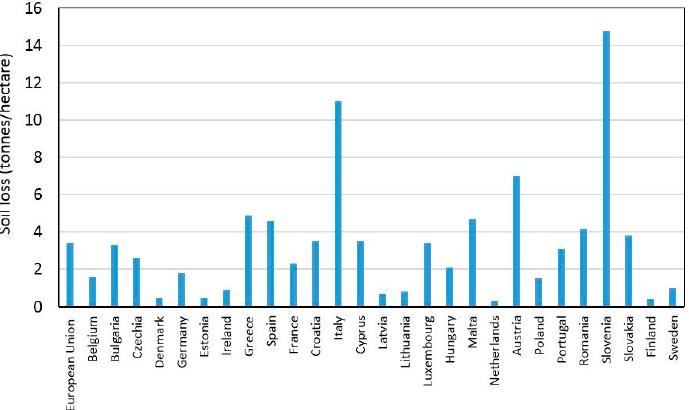
Figure 4. Estimated soil loss by water erosion in countries of the EU, data from [70], 2016.